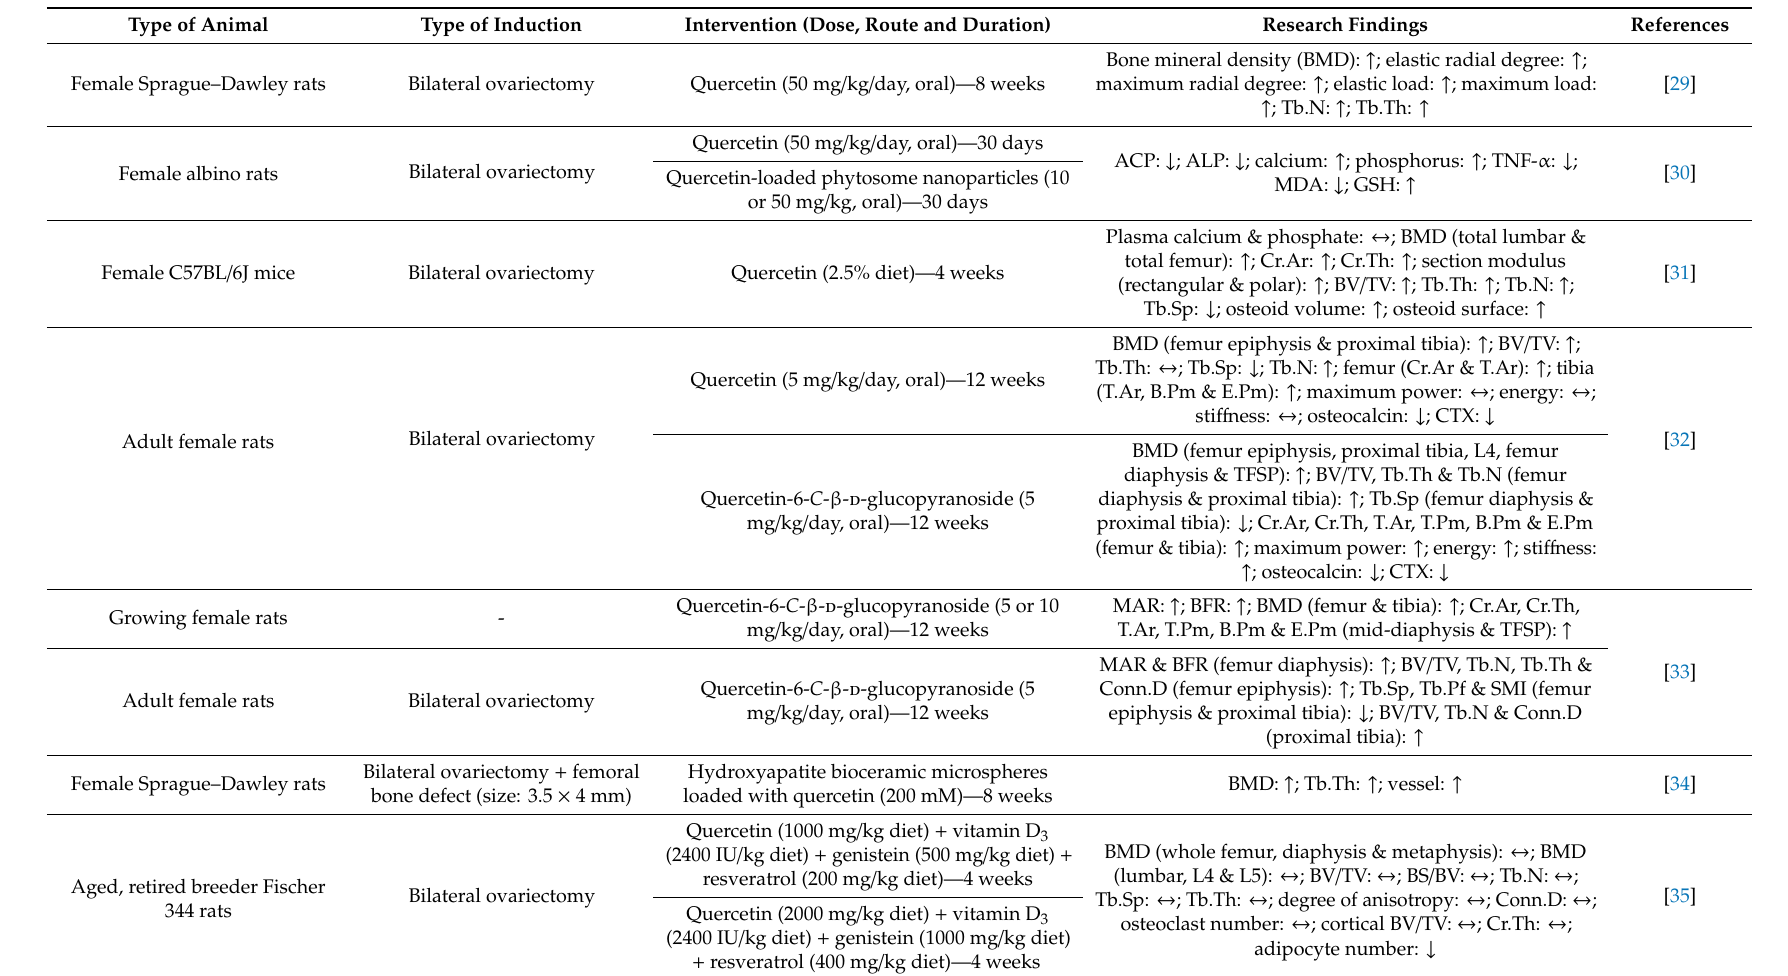
Table 1. The e ff ects of quercetin on bone in in vivo studies. Symbol ↑ indicates an increase or upregulation, ↓ indicates a decrease or downregulation and ↔ indicates no